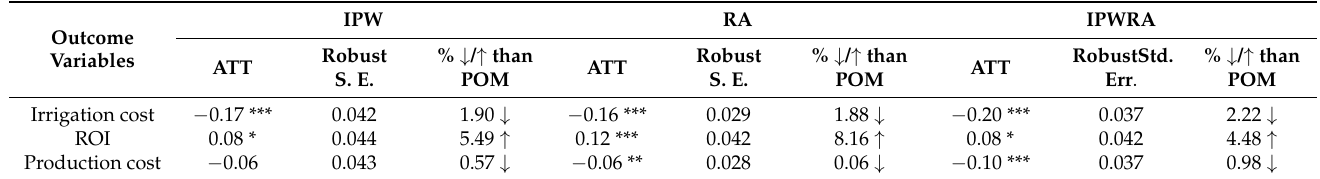
Table 5. Average treatment effects of solar irrigation adoption on outcome variables.